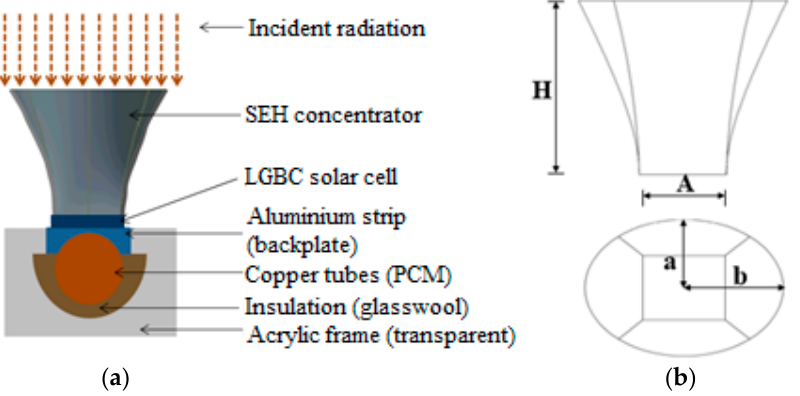
Figure 2. ( a ) Cross-sectional view of the designed system and ( b ) design of the SEH concentrator with specific dimensions of H = 30 mm, A = 10 mm, a = 24 mm, b = 33 mm; adapted from [26].